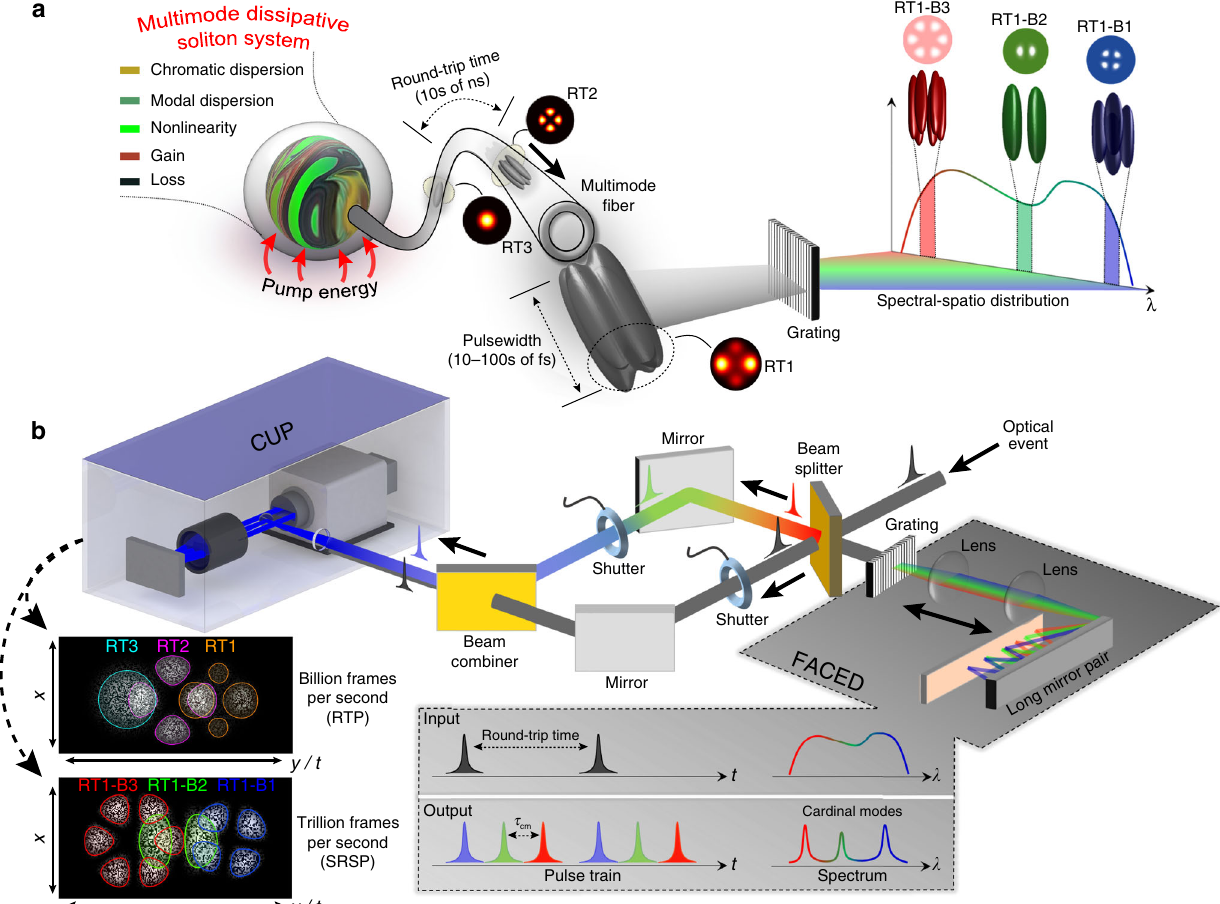
Fig. 1 Spatio-temporal-spectral laser dynamics in a multimode DS system and schematic diagram of STS-CUP. a Multimode DS (dissipative soliton) system involving composite balances between multiple optical effects, where multiple transverse and longitudinal modes are simultaneously locked together to create ultrashort (fs) pulses. Inherited from the complexity of an optical dissipative system, a variety of spatio-temporal pro fi les can be generated over round trips, e.g., round trips 1 – 3 (RT1 – 3) illustrate different spatial cross-sections of 3D ultrashort laser bullets (typically 10 – 100 fs after dechirping). Owing to the nature of wavelength-dependent lightwave propagation in MMFs, a single pulse can exhibit different spatial pro fi les in different spectral bands (RT1-B1 – 3, note, the spatial pro fi les shown here are arbitrarily chosen for conceptual visualization, while much more complex cases could occur in reality, e.g., the one in Fig. 5), which can be resolved using optical gratings. b Schematic diagram of STS-CUP (spatio-temporal-spectral compressed ultrafast photograph). The fs optical event from the multimode DS system is split by a beam splitter into two branches that are respectively used for observations of round-trip pulses (RTPs) and spectrally resolved single pulse (SRSP). For the former case, the optical event is directly launched to the CUP unit (Supplementary Fig. 1). For the latter case, a single optical event is imparted with wavelength-dependent time delay through a free-space angular-chirp-enhanced delay (FACED) device. The optical spectrum of a single optical event is segmented into multiple spectral bands according to the cardinal modes of the FACED “ cavity, ” while each cardinal mode (spectral band) has a different time delay, typically 100s of ps ( τ cm , right bottom inset). The spectrally resolved sub-pulses of a single optical event are then captured by the CUP unit. The STS-CUP system operates at speeds of billions or trillions of frames per second in RTP and SRSP modes,